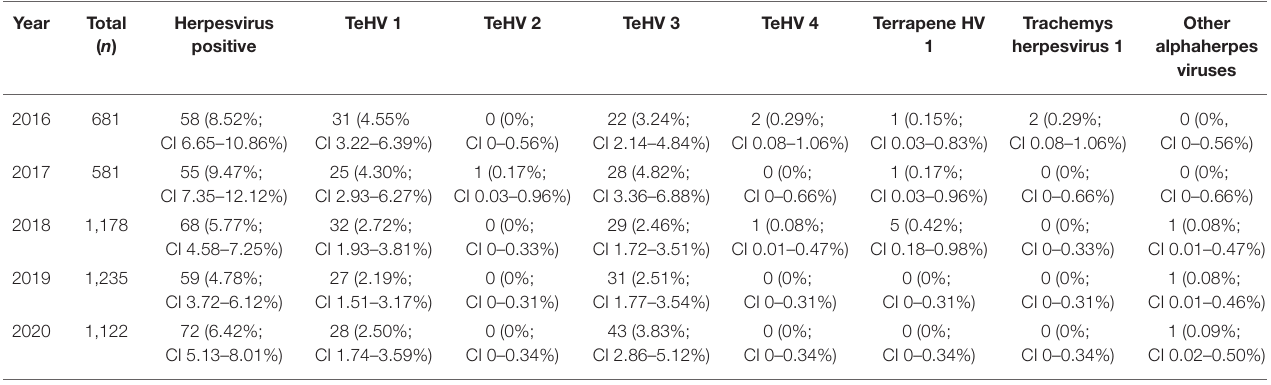
TABLE 2 | Herpesvirus positivity rate according to virus strain and year of sampling.